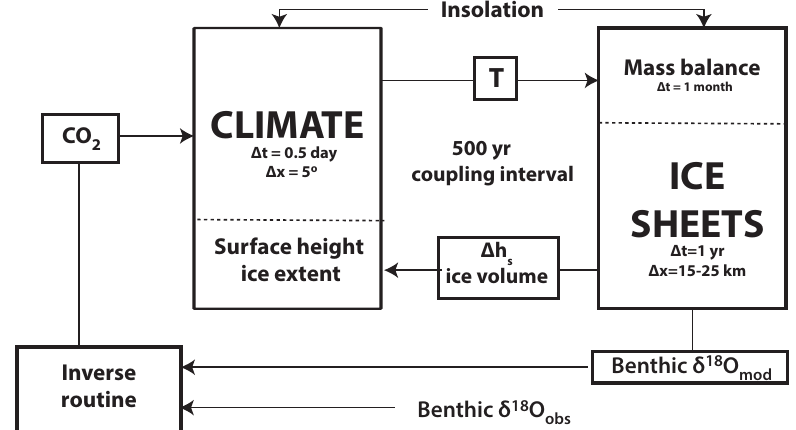
Figure 1. Schematic overview of the coupling of the zonally averaged energy balance climate model and the one-dimensional ice sheet